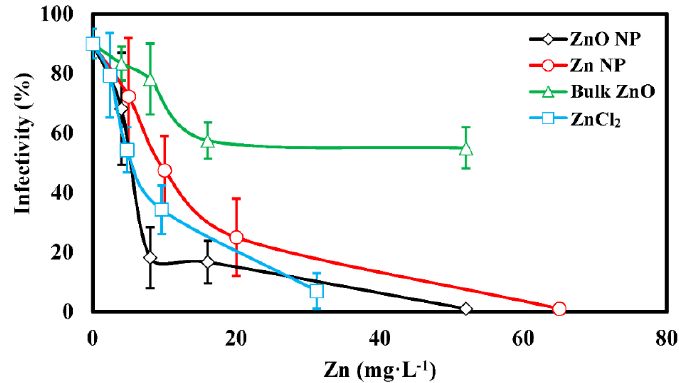
Figure 6. Percentage of tobacco plants infected by P. tabacina in the presence of Zn treatments. Error bars = standard deviation.